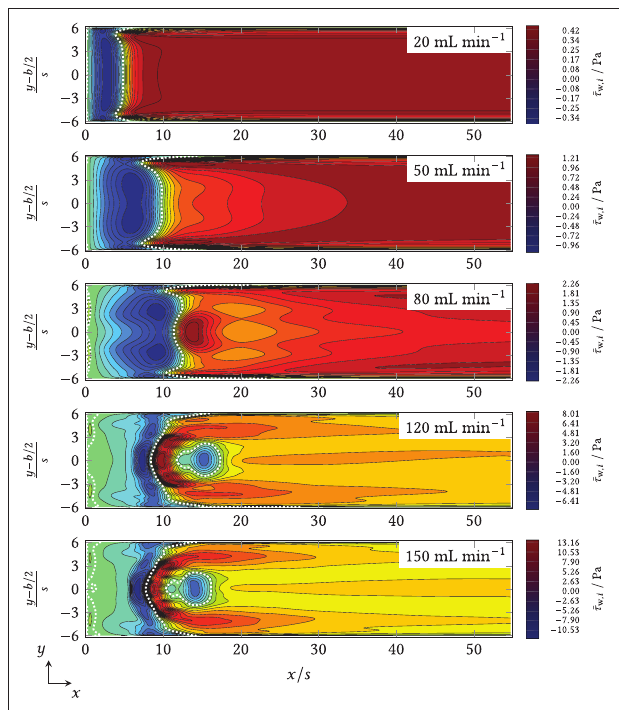
FIGURE 7 | x -component of the time-averaged wall shear stress ( τ w, i ) in the zone downstream of the step ( x / s = 0) for ˙ V = { 20,50,80,120,150 } mL min − 1 (from top to bottom). The channel width (shown here as y -axis) was also normalized to the step height, s , and centered, according to